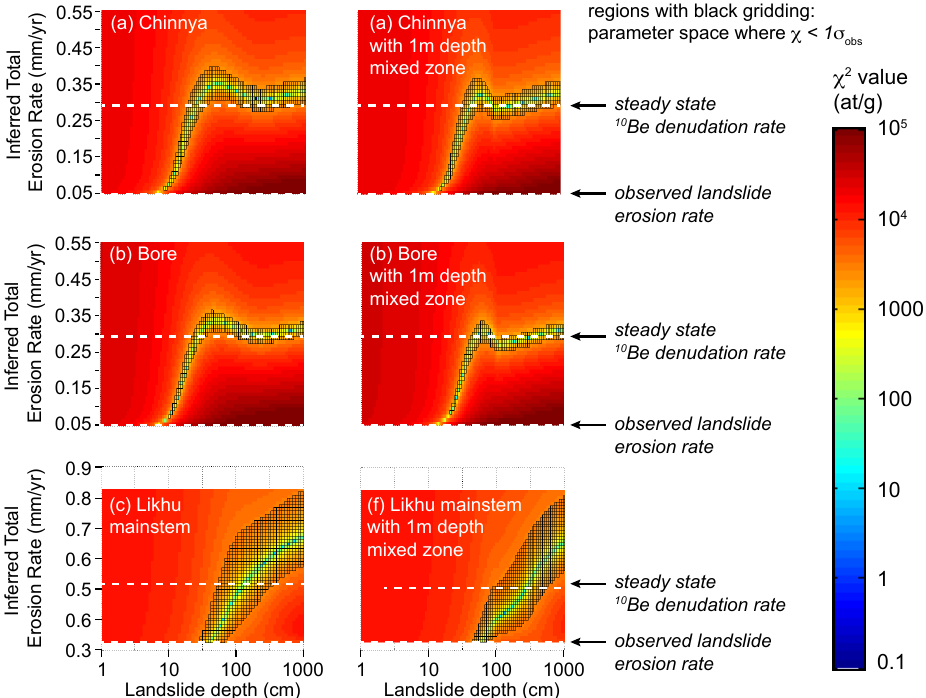
Figure A1. Results of model testing sensitivity of denudation rates estimates to mass wasting. Results from model calculating 10 Be qtz produced in sediment from repeated landslides of a characteristic depth, z ls , where the return time is fixed so that the total landslide flux adds up to the observed mass wasting flux in each catchment. Color shading shows the χ 2 value describing the misfit between modeled 10 Be 10 Be qtz concentration and the observed sediment qtz concentration. Gridded regions define parameter space where the misfit ( χ ) is less than analytical uncertainty, reflecting combinations of z ls and denudation rate that fit the data. The values of that fit the data (i.e., those within the gridded region) depend on the depth of landslides, but the pattern is relatively insensitive to the depth of mixing in the surface soil layer. The lowest possible value for is set by the imposed landslide erosion rate (the lower white, dashed line). For very small landslides (which must occur more frequently), the river sediment 10 Be concentration could be explained by total denudation rates that approach this landslide rate, requiring little to no additional, non-landslide erosion. In this case, a long-term denudation rate calculated assuming steady state would overestimate actual long-term rates (i.e., for values of z ls on the x axis where white dashed line for steady-state rate is higher than the χ 2 valley). However, small landslides (<50cm) probably do not dominate the erosional budget, and for realistic depth of landslides in the Bore and Chinnya (> ∼ 50cm), rates calculated on the basis of a steady-state assumption closely approximate the long-term rate in the model (where the χ 2 valley coincides with the steady-state value in panels (a) , (b) , (d) , and (e) ). For the Likhu main stem (c, f) , with higher landslide erosion rate, potential bias is more significant, though the larger size of this catchment may average stochastic landslide events (cf. Niemi et al., 2005; Yanites et al., 2007). Note that the model shown here is for a highly simplified system with landslides of uniform size and return frequency, and fixed landslide erosion